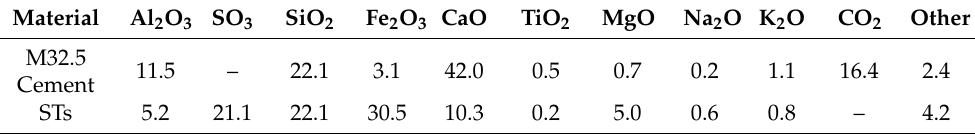
Table 1. The main chemical composition of M32.5 cement and STs (wt./%).